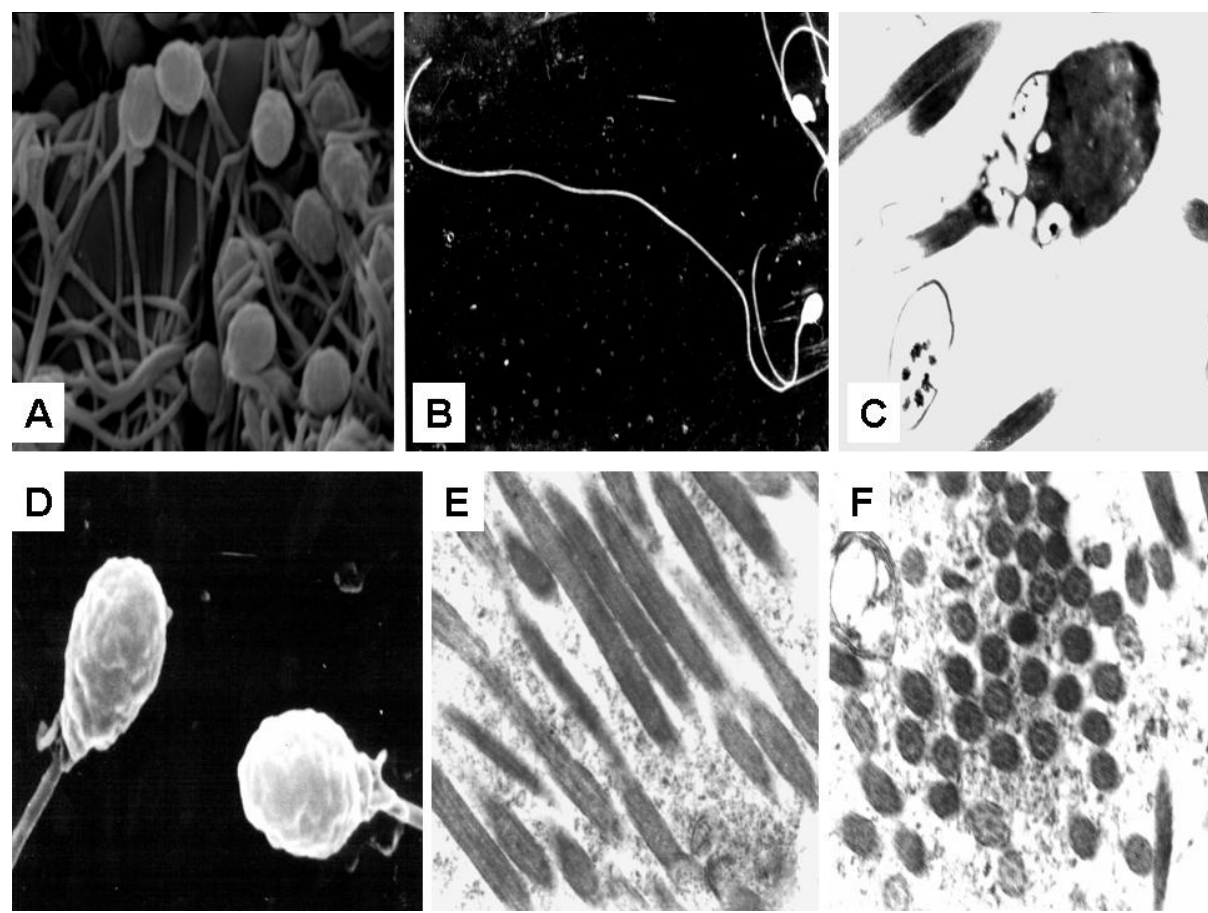
F IG . 1. – Spermatozoa in the lobules of the rip testis of Clarias gariepinus ( A : × 10000). The structures of the spermatozoa as revealed by SEM (B, C) in semen ( × 3500) and TEM ( × 20000). The irregularity of sperm head and midpiece were evident with a very long tail (B) and